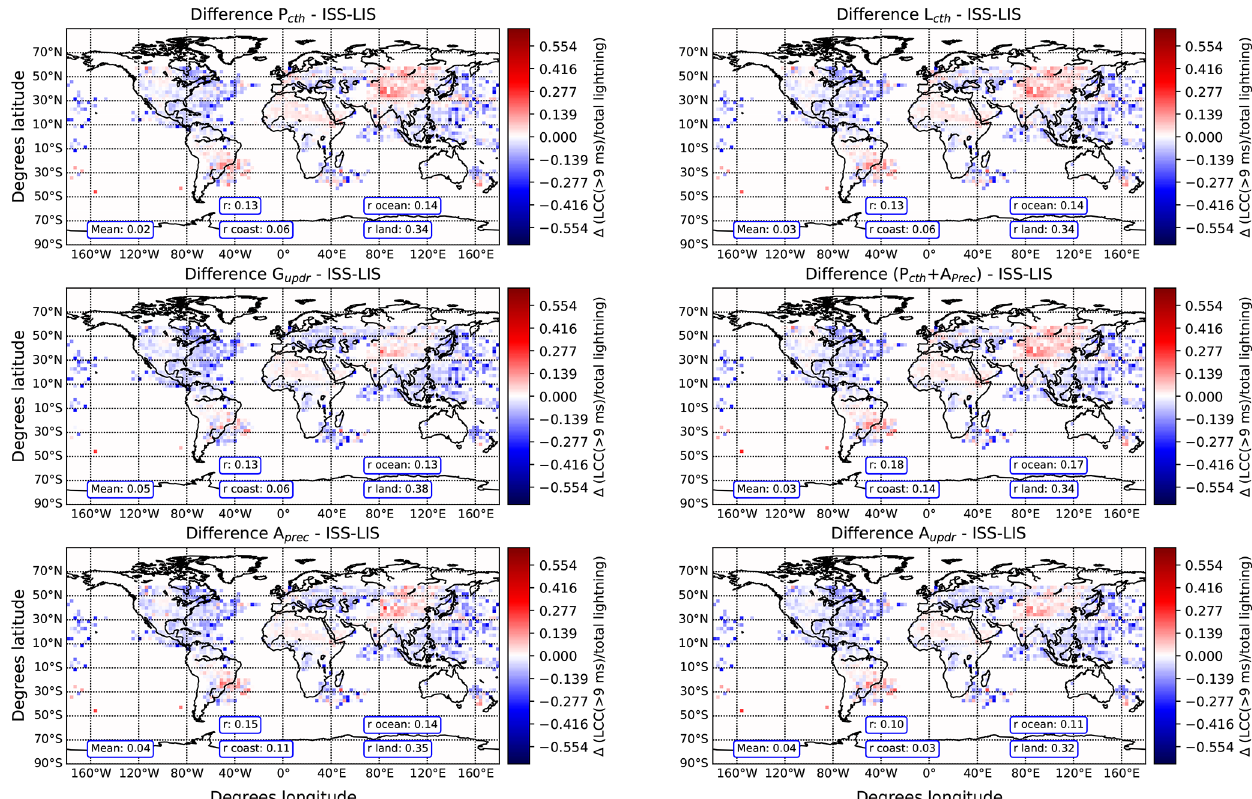
Figure 11. Difference between the observed and simulated ratio of LCC( > 9ms) lightning to total lightning density in June, July, and August using different lightning parameterizations. Positive values indicate that the model overestimates the ratio. The calculated global, land, and ocean spatial correlation coefficients r are